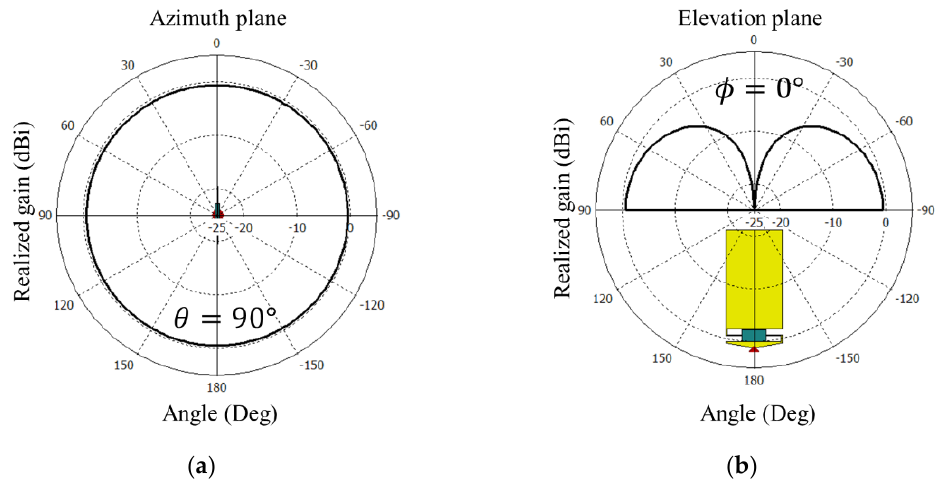
Figure 17. Simulated radiation pattern of the miniaturized and matched antenna A5 at the frequency 130 MHz . ( a ) in azimuth plane ( b ) in elevation plane.